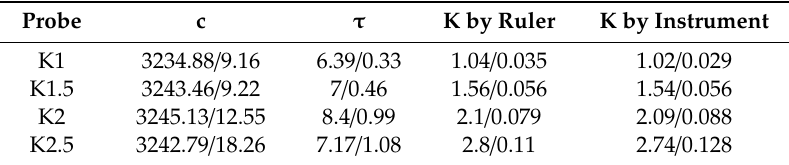
Table 3. Results of calibrations (mean / standard deviation).